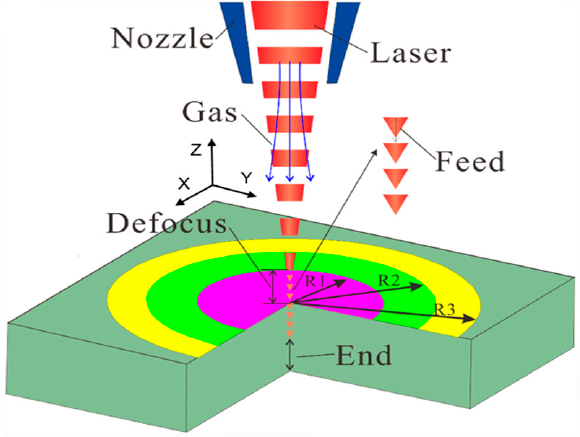
Figure 3. Schematic diagram of annular drilling. Table 2. Factors and levels.